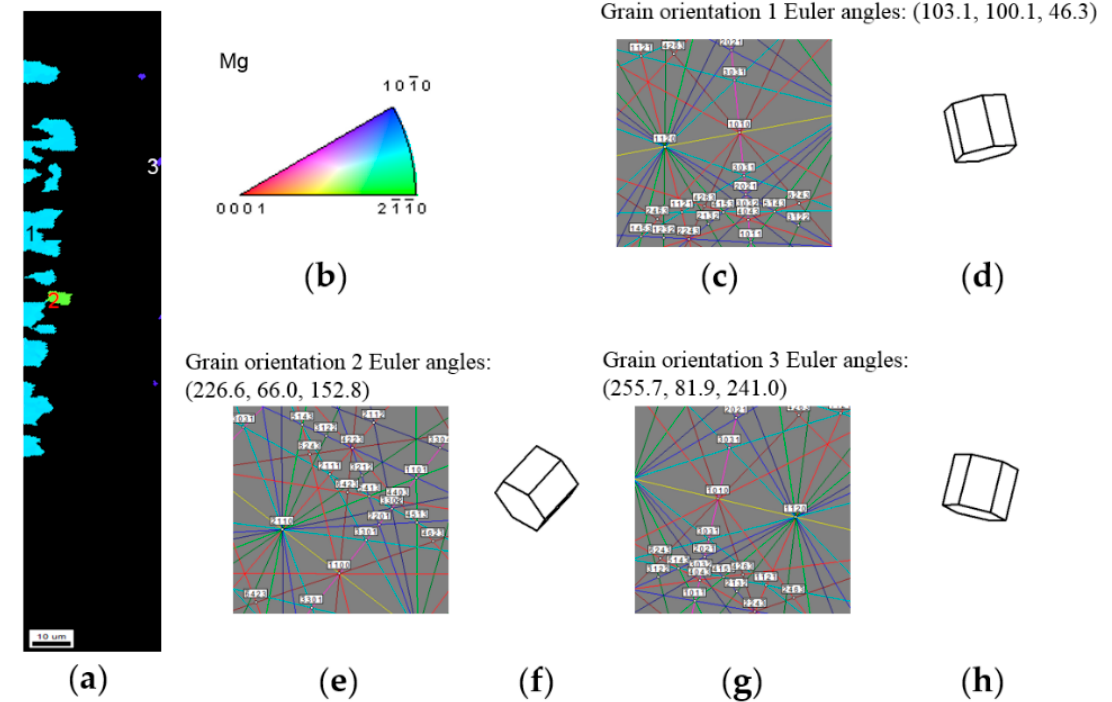
Figure 9. ( a ) IPF and EBSD mapping; ( b ) color assignment; ( c ) EBSD pattern for grain orientation 1 and ( d ) its corresponding crystal simulation; ( e ) EBSD pattern for grain orientation 2 and ( f ) its corresponding crystal simulation; and ( g ) EBSD pattern for grain orientation 3 and ( h ) its corresponding crystal simulation of the Mg phase of the 16-h annealed sample.